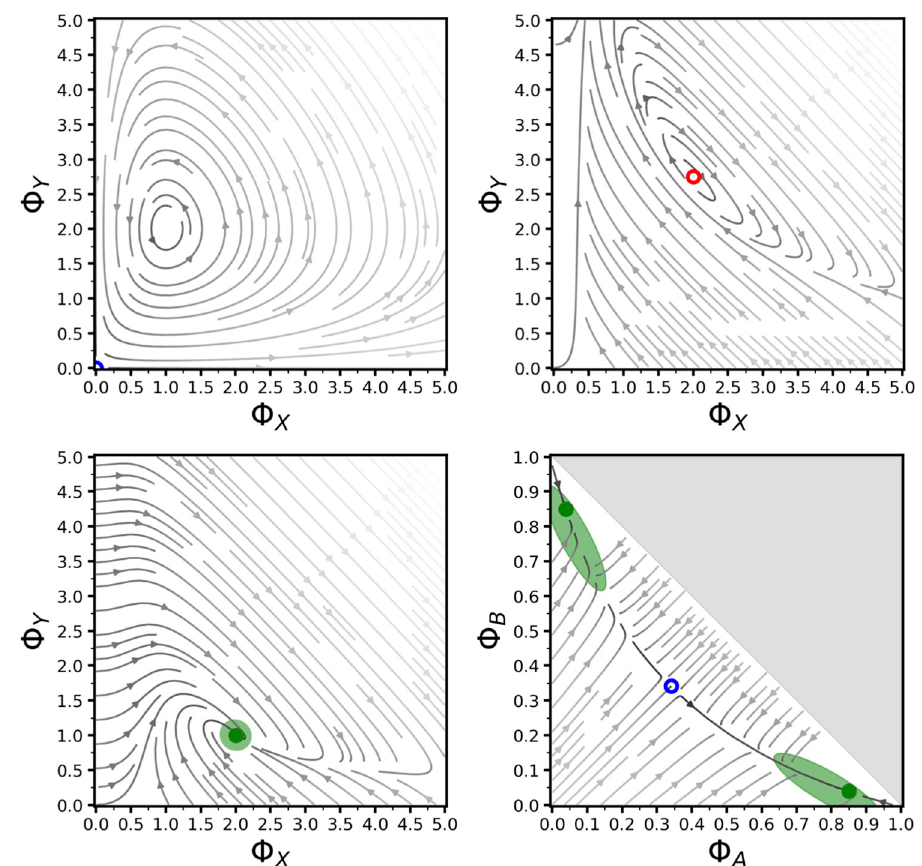
Fig 4. Phase portraits with computed fixed points and noise. Upper-left: oscillatory dynamics in the Lotka-Volterra equations ([3], p.79) (parameters F A = α = β = γ = 2.0). Upper-right: limit cycle in the Brusellator ([3], p.253) (parameters F α = χ = δ = γ = ξ = 2.0, F β = 5.5). Lower-left: global attractor with isotropic noise in the Brusellator ([3], p.253) (parameters F α = F β = χ = δ = γ = ξ = 2.0, system size = 10). Lower-right: co-existence of two stable attractors in the honeybee swarming model [2], with anisotropic non-axis-parallel noise (parameters Δ = 0.0, μ = 3.0, s = 10.0, system size = 20, runs = 100). Line shading indicates speed of flow, with darker representing faster. Fixed points are denoted as stable (dark solid green circle), saddle (hollow blue circle), or unstable (hollow red circle). Light green ellipses represent 1- σ noise around stable fixed